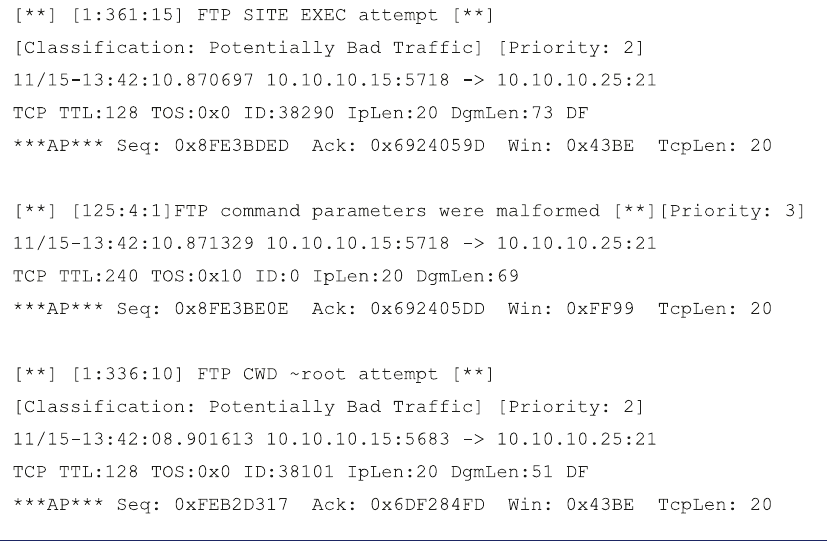
Figure 10: Snort alert snapshot.